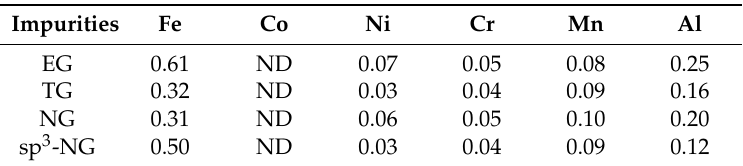
Table 2. The contents of the typical 3-D metal impurities of the samples. The unit is ‘ppm’. ‘ND’ denotes ‘not